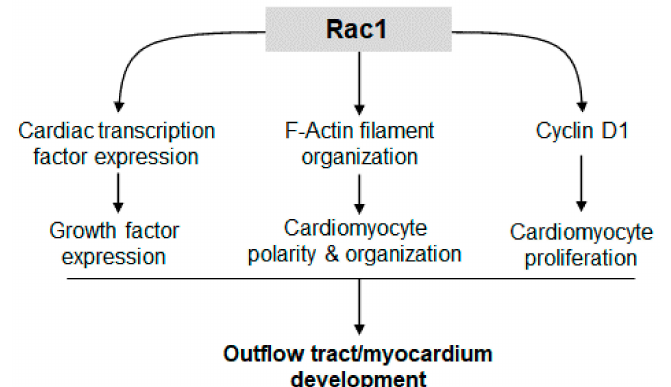
Figure 9. Rac1 signaling promotes cardiac transcription/growth factor expression, cardiomyocyte polarity and proliferation, leading to normal development of the outflow tract and compact my-